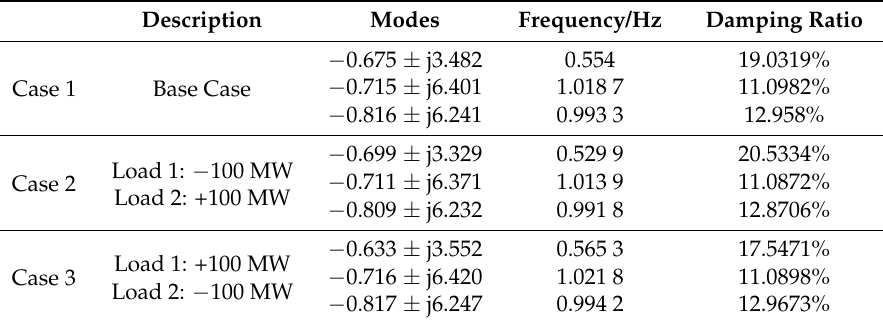
Table 3. Characteristics of modes in three load cases with FACTS